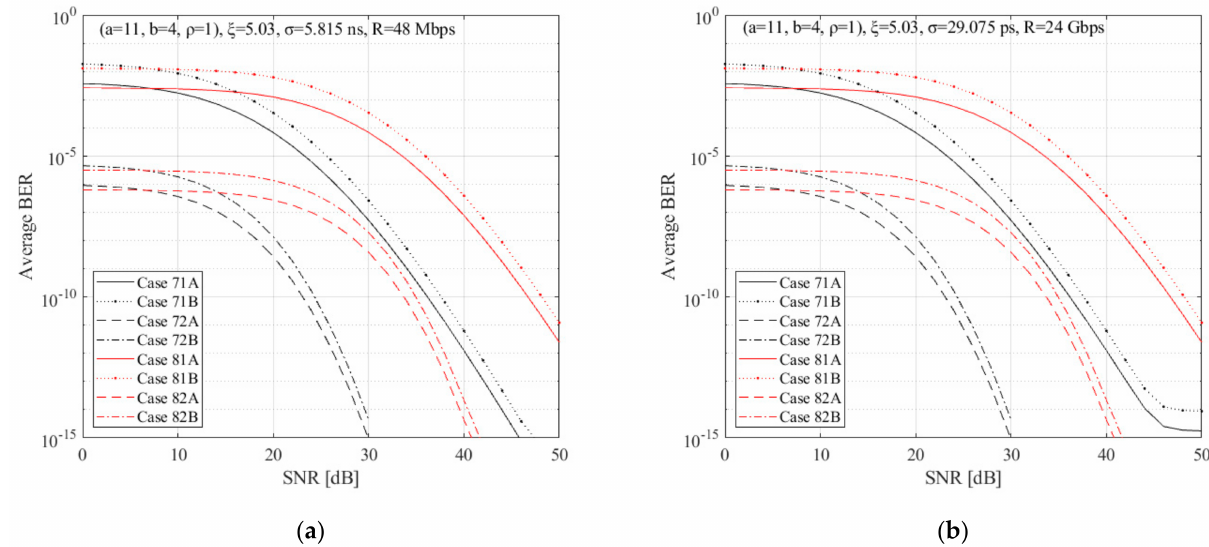
Figure 7. ABER versus expected SNR for ( a = 11, b = 4, ρ = 1), ξ = 5.03, L -PAM schemes, and various diversity and DF multi-hop parameters, with ( a ) R = 48 Mbps, σ = 5.815 × 10 − 9 s ( α = 10 − 8 s, β = 4), and ( b ) R = 24 Gbps, σ = 29.075 × 10 − 12 s ( α = 5 × 10 − 11 s, β = 4). The studied curve cases are codified as follows: Case 71A: 4-PAM, N = 3 , M = 1; Case 71B: 4-PAM , N = 3 , M = 5; Case 72A: 4-PAM , N = 9 , M = 1; Case 72B: 4-PAM , N = 9 , M = 5; Case 81A: 16-PAM , N = 3 , M = 1; Case 81B: 16-PAM , N = 3 , M = 5; Case 82A: 16-PAM , N = 9 , M = 1; Case 82B: 16-PAM , N = 9 , M =